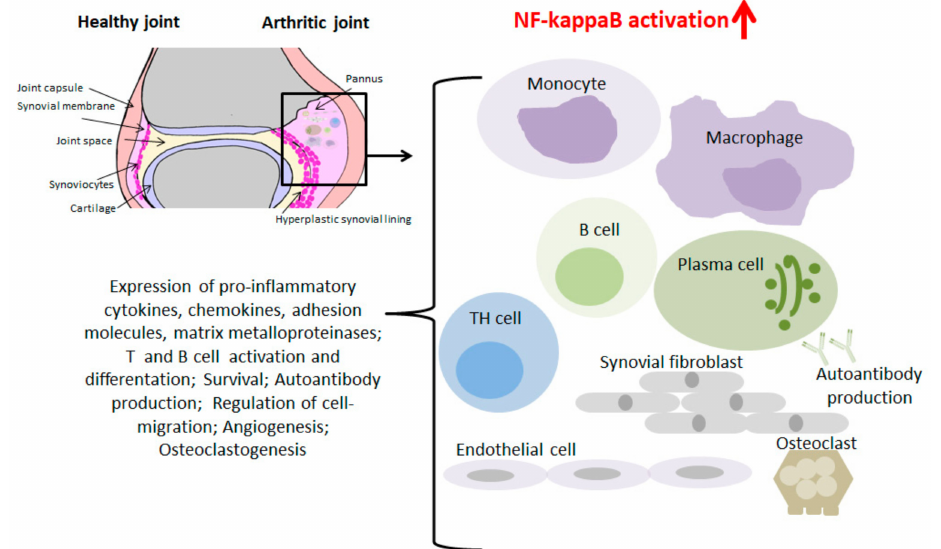
Figure 2. Role of NF-kappaB in RA. A Healthy and an arthritic joint is presented. Monocytes / macrophages, TH cells, B cells, plasma cells, synovial fibrobasts, endothelial cells, and osteoclasts contribute to RA pathogenesis. Induction of NF-kappaB target genes promotes inflammation leading to cartilage and bone